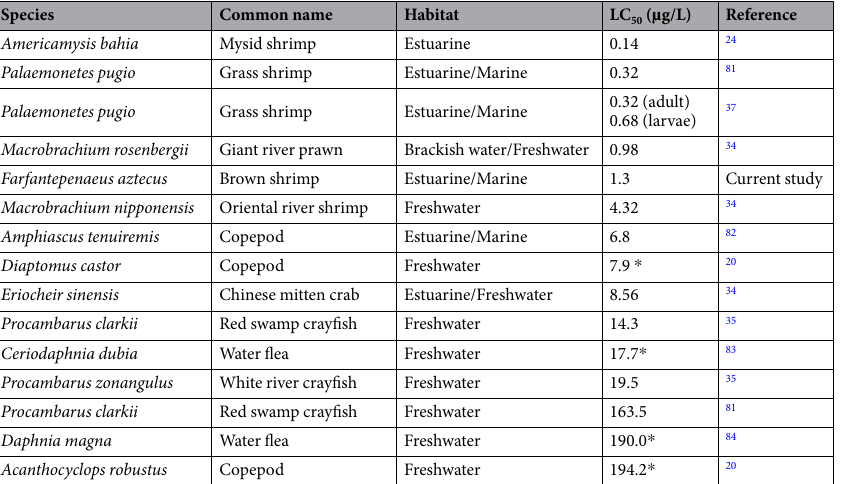
Table 3. Median lethal concentration (LC 50 ) for F . aztecus and other estuarine and freshwater arthropods (Crustacean species) exposed to fipronil for 96-h in toxicity tests. Values with star ( * ) indicate LC 50 for48-h exposure. Table was modified from Chandler et al . 82 .